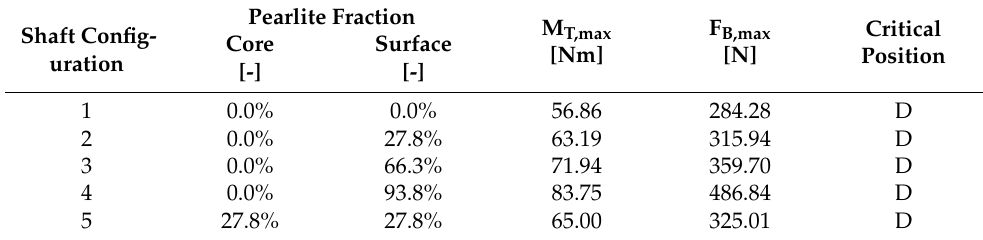
Table 6. Maximum allowable cyclic load M T,max and F B,max